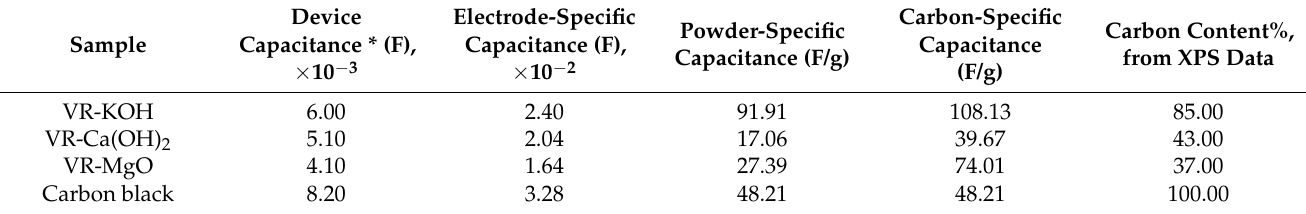
Table 3. Summary of specific capacitance analyzed from 2-electrode cell